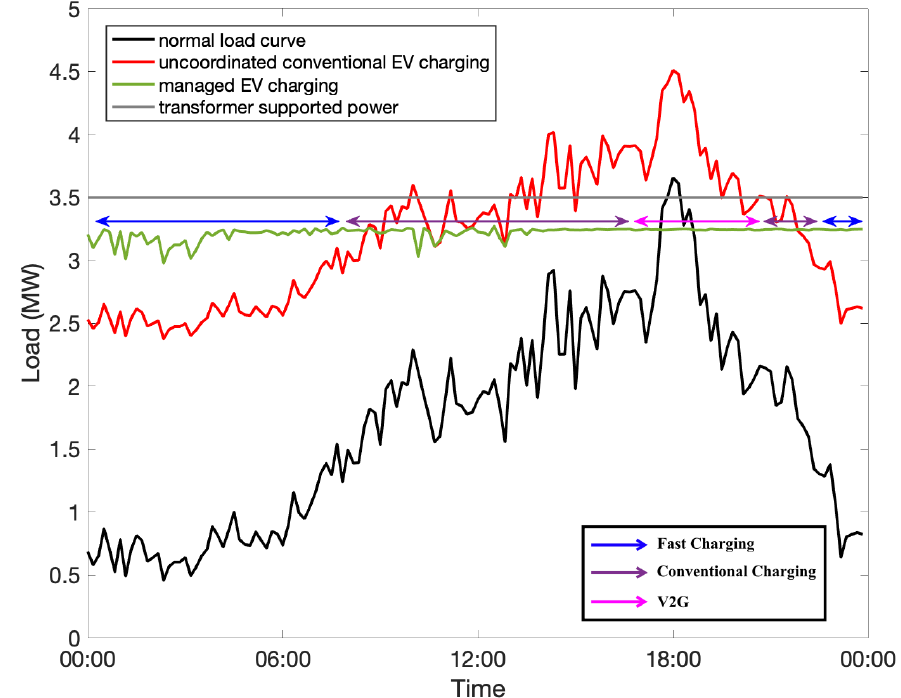
Figure 3. Comparison of load curves of different